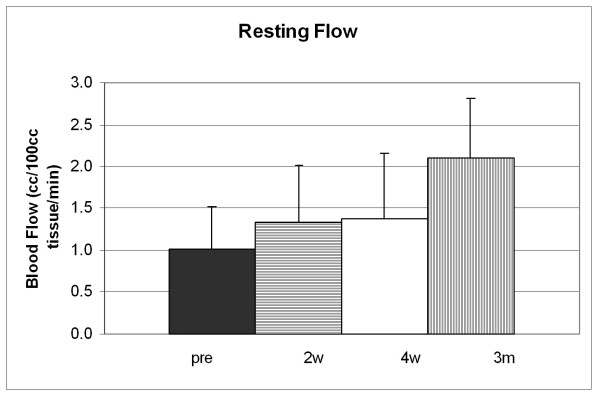
This figure shows the blood flow in the forearm of the subjects with diabetes at rest (cc/ 100 ml tissue/minute) before taking rosiglitazone (pre) and at two weeks (2 w), four weeks (4 w), and three months (3 m) taking 4 ml per day of Rosiglitazone. All data is shown with the appropriate standard deviation.